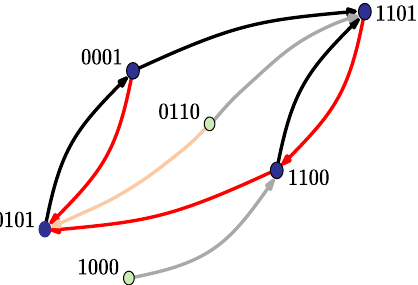
FIG. 1. State transition graph of antibiotic resistance evolution. The nodes depict genotypes composed of four mutations in the antibiotic resistance enzyme TEM-50 β -lactamase. Genotypes are represented as binary strings where a 1 denotes the presence and 0 the absence of a specific mutation. The growth rates of bacteria expressing these mutant enzymes were reported in Ref. [21] for the antibiotic piperacillin at three different concentrations (128, 256, and 512 μ g = ml). Each node is a local fitness maximum at one of these concentrations. Black and gray arrows connect nodes that would be reached under adaptive evolution when the concentration is increased, and red and orange arrows represent the dynamics under concentration decrease. For example, 0001 is a local maximum at 256 μ g = ml, but when the concentration is switched to 512 μ g = ml,itisnolongerafitnessmaximum.Evolutionthrough a greedy adaptive walk (where every step is maximally fitness increasing) leads to the new maximum 1101. The graph displays a hysteresis loop 0101 → 0001 → 1101 → 1100 → 0101 . The green nodes are transient and cannot be reached under cyclic concentration changes. Gray and orange arrows mark transitions out of transient